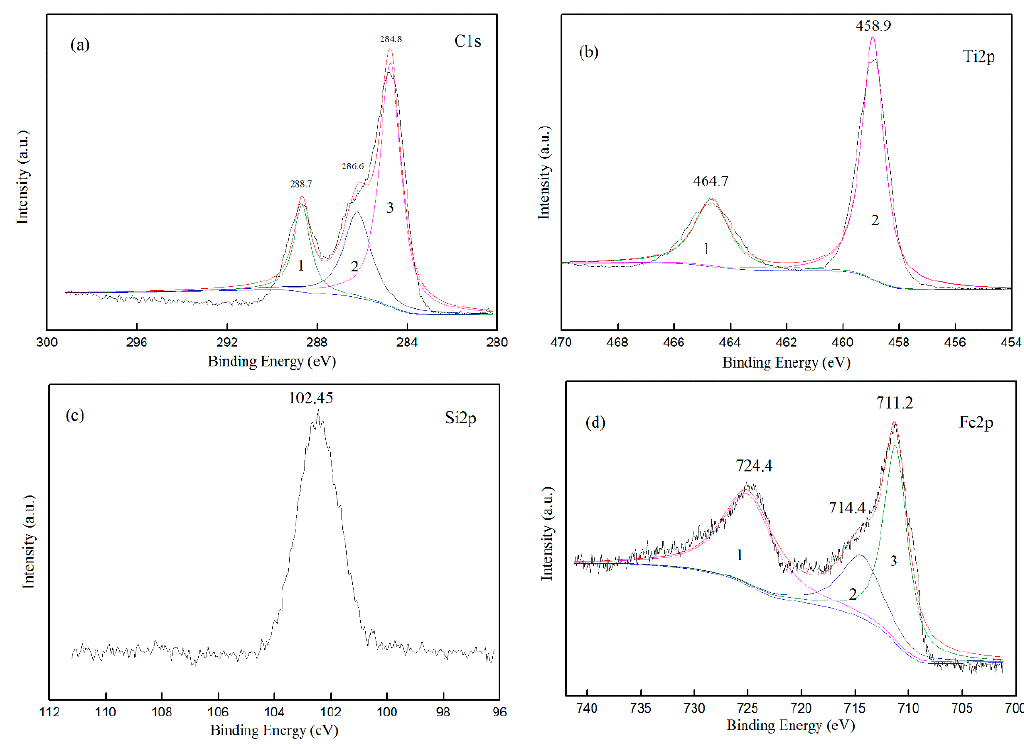
Figure 9. XPS spectra of Fe 3+ -doped STCF: ( a ) C1s; ( b ) Ti2p; ( c ) Si2p; and ( d ) Fe2p.